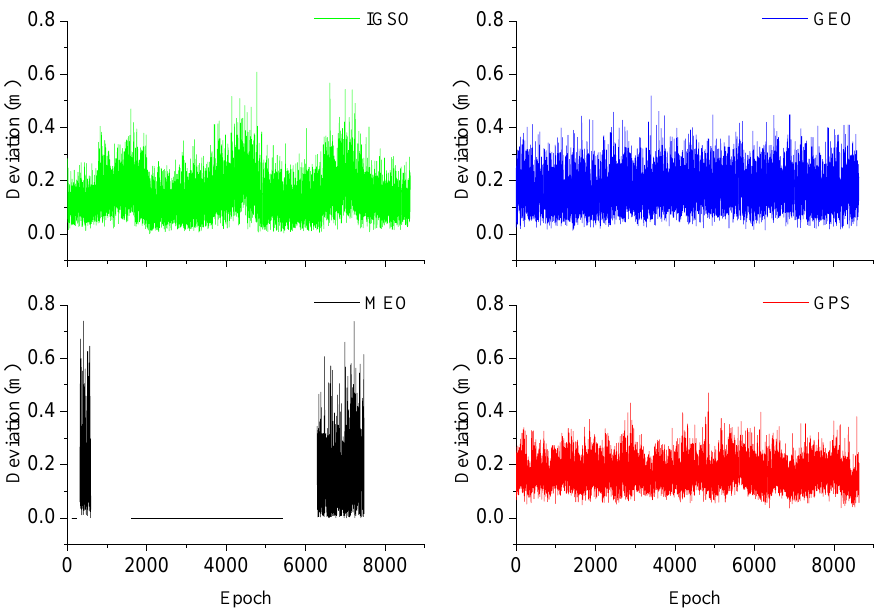
Figure 4. Trimble C/A code measurement precision deviations for GPS, BeiDou GEO, IGSO, and MEO satellites.